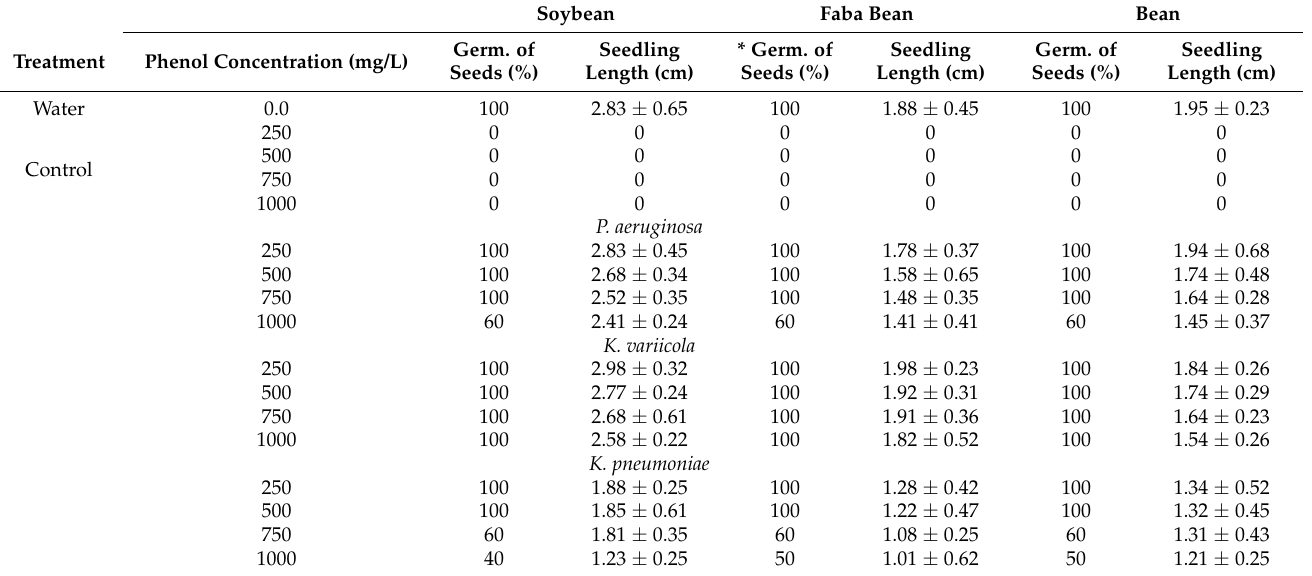
Treatment Phenol Concentration (mg/L)